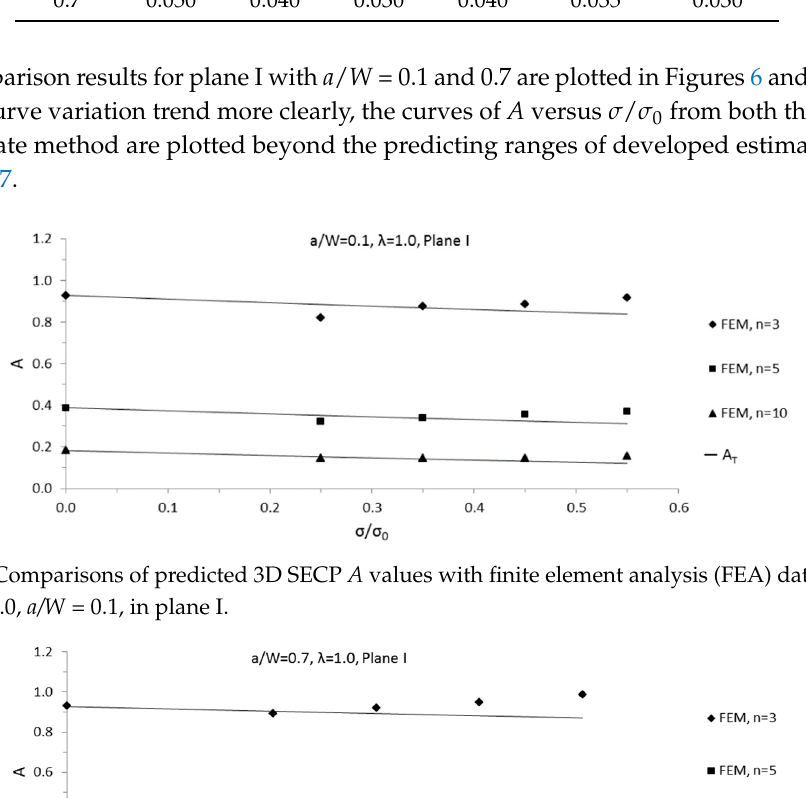
Table 5. Maximum predicting loads ( σ / σ 0 ) for 3D SECP under uniaxial loading ( λ = 0.0), in plane I and